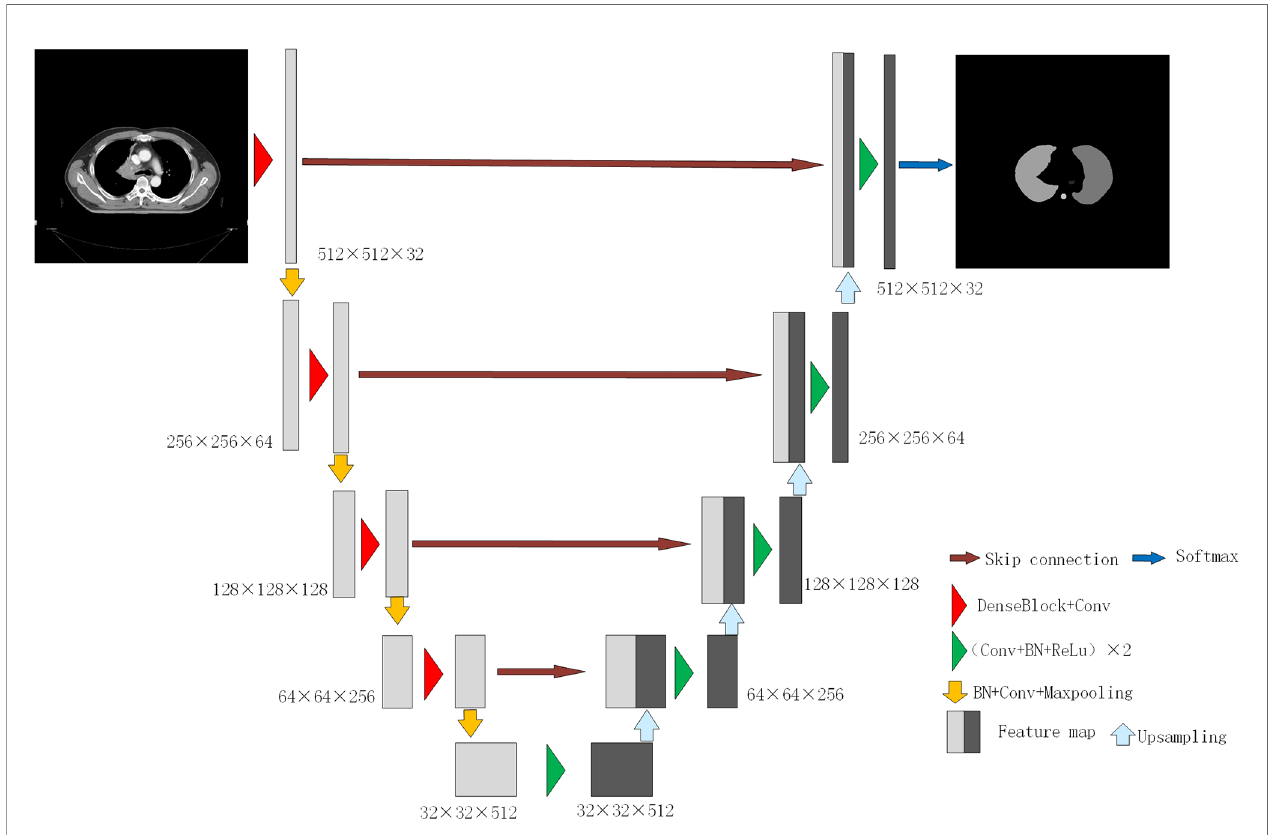
FIGURE 2 | The architecture of the proposed